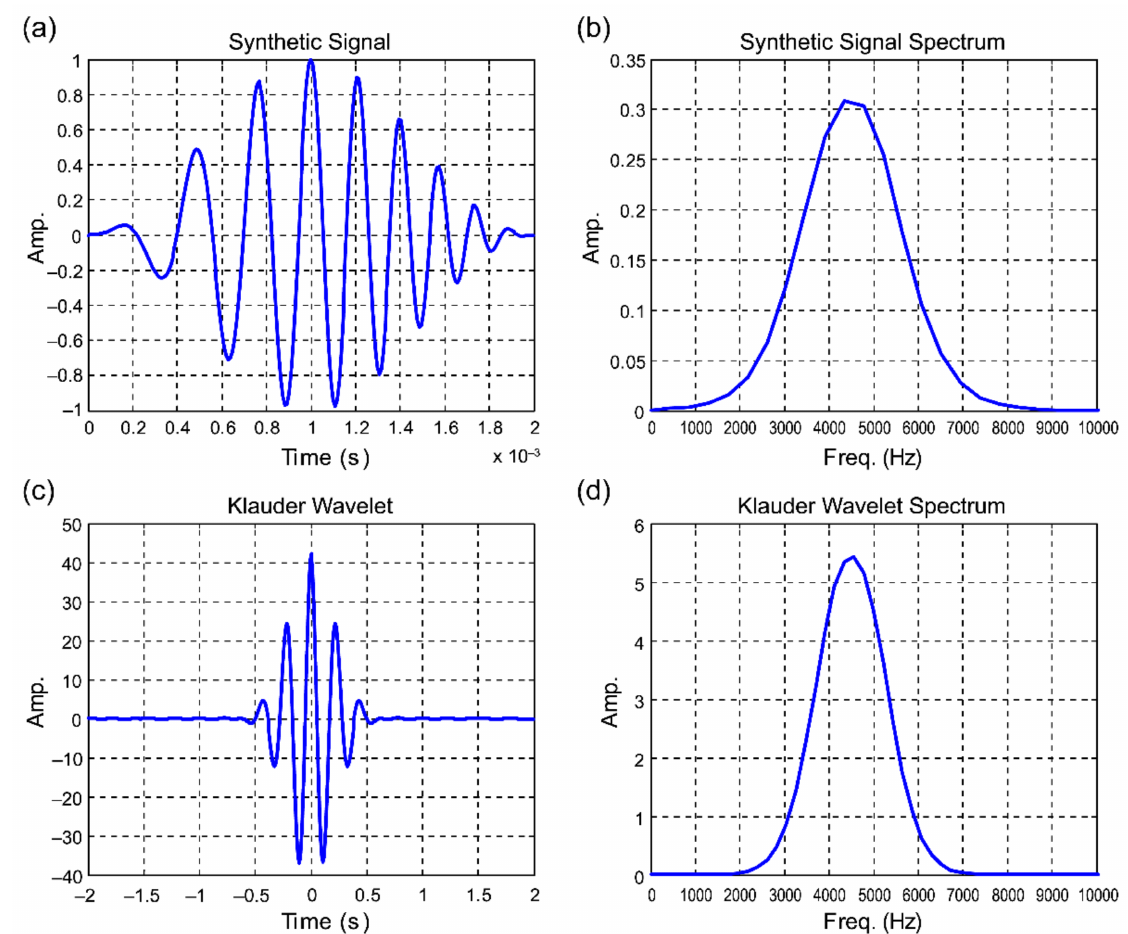
Figure 7. ( a ) Chirplet with 2–7 kHz frequency over a 2 ms duration (taper time: 2 ms). ( b ) Amplitude spectrum of ( a ). ( c ) Klauder wavelet obtained by autocorrelation of ( a ). ( d ) Amplitude spectrum of ( c